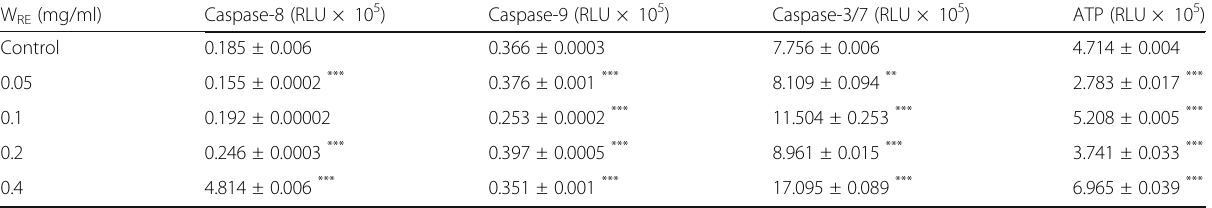
Table 2 Modulation of caspase (-8, -9, -3/7) activity and ATP levels in LPS stimulated and 24 h W RE treated PBMC ’ s W RE (mg/ml)